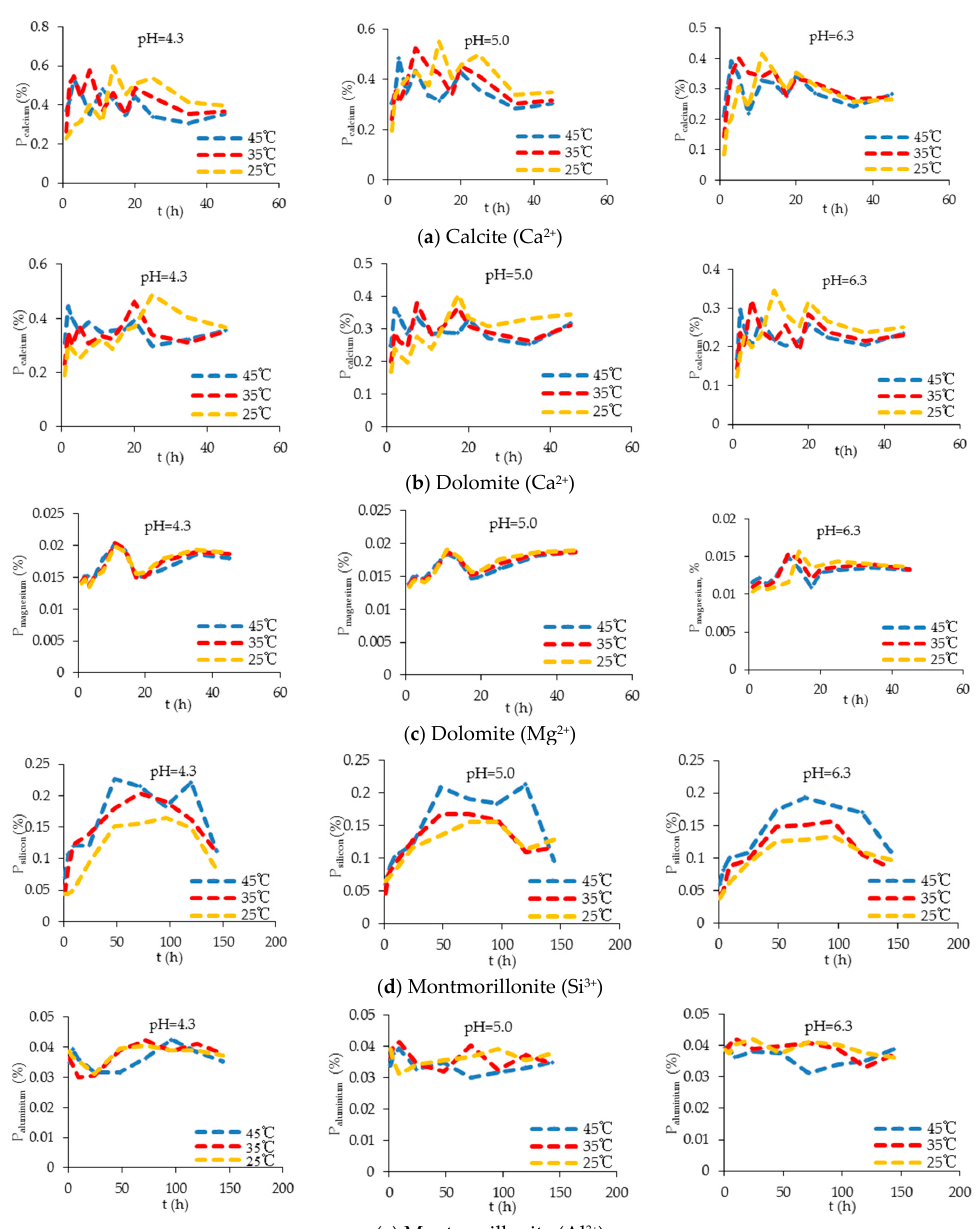
Figure 6. Dissolving-out ratio (P)–time profiles for dissolutions of calcite ( a ), dolomite ( b , c ), montmorillonite ( d , e ) in respective reaction solutions under different temperatures and pH values.